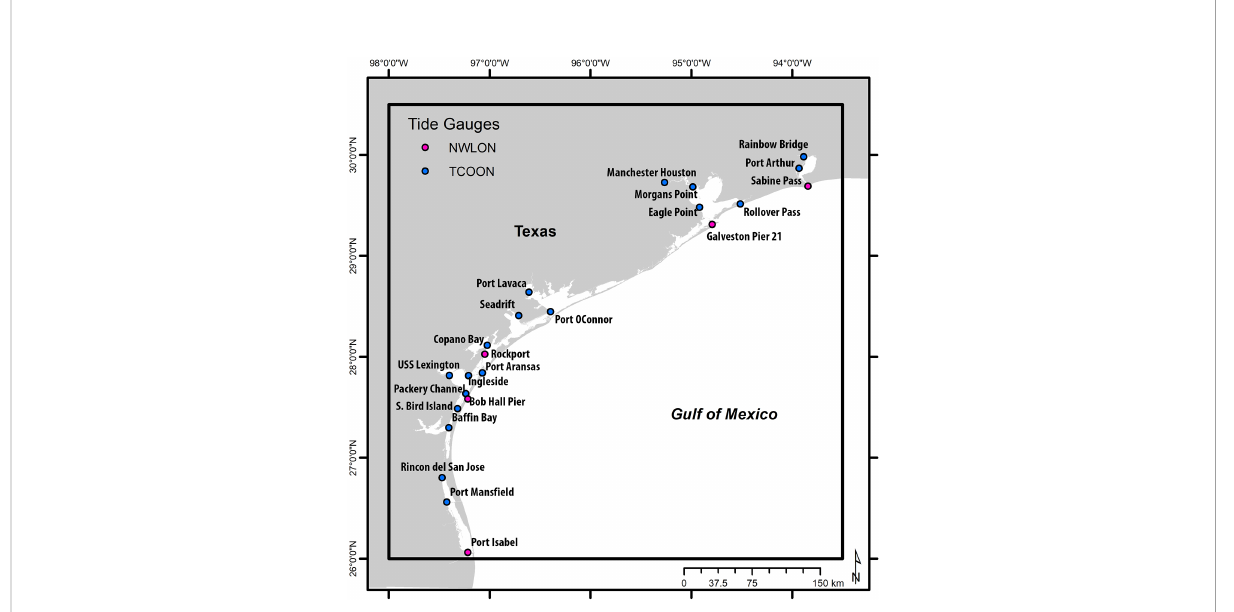
FIGURE 1 A map of TCOON and NWLON tide gauge stations. The rectangular box indicates the area used for calculating average